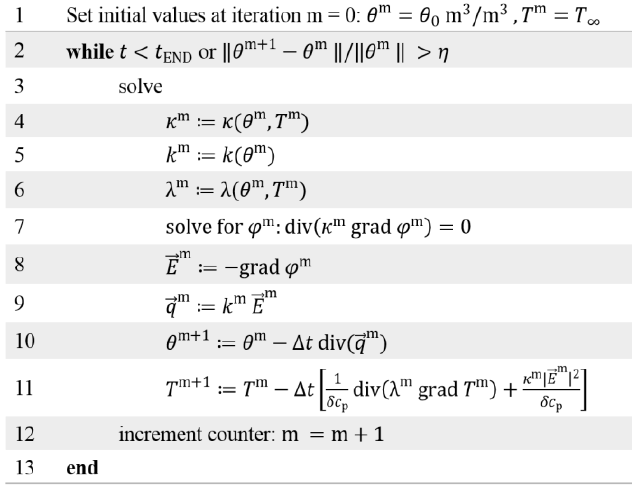
Figure 24. Pseudo code to obtain the time-varying humidity concentration ( θ ), the temperature ( T ) and the electric field ( E ) [128].